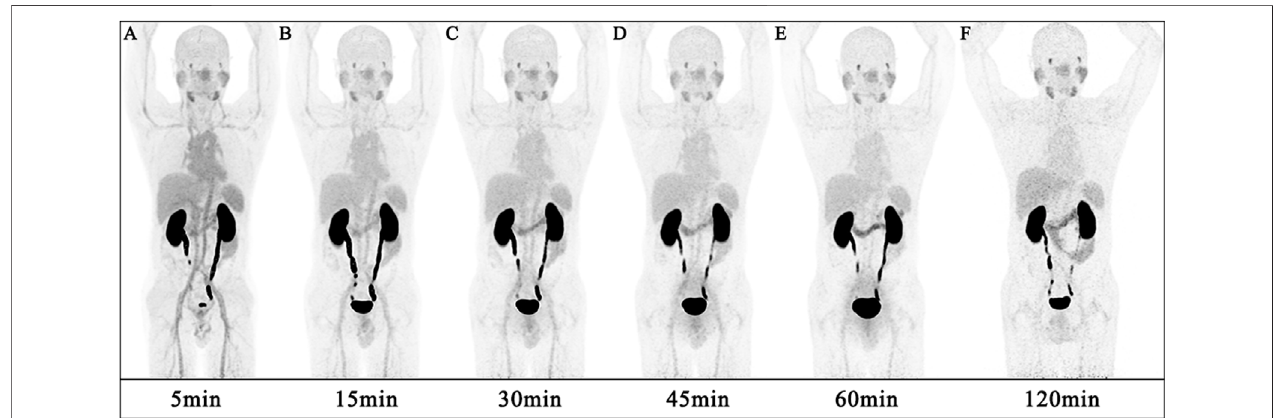
FIGURE 2 | A maximum intensity projection PET images at several time points post-injection of a 56-year-old male healthy volunteer.